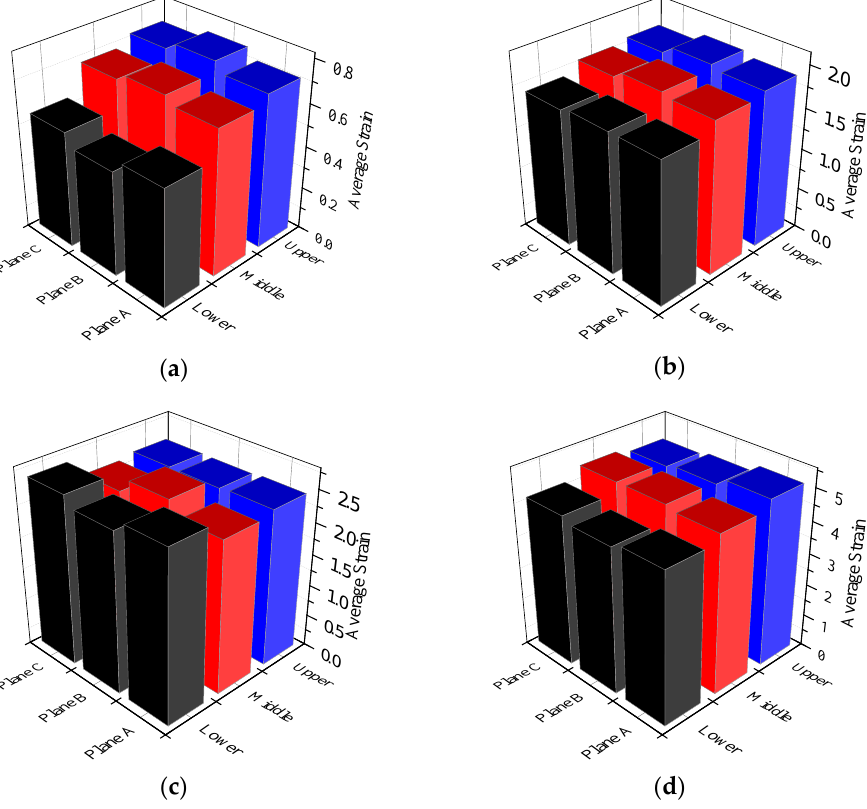
Figure 5. Average strain distribution in the different planes of Ti 49.2 Ni 50.8 alloy processed by ECAP for different passes: ( a ) 1 pass; ( b ) 3 passes; ( c ) 4 passes; and ( d ) 8 passes.